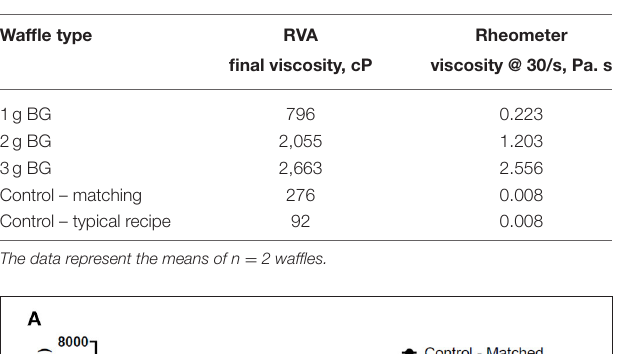
TABLE 3 | In vitro viscosity of waffles containing different BG concentrations.